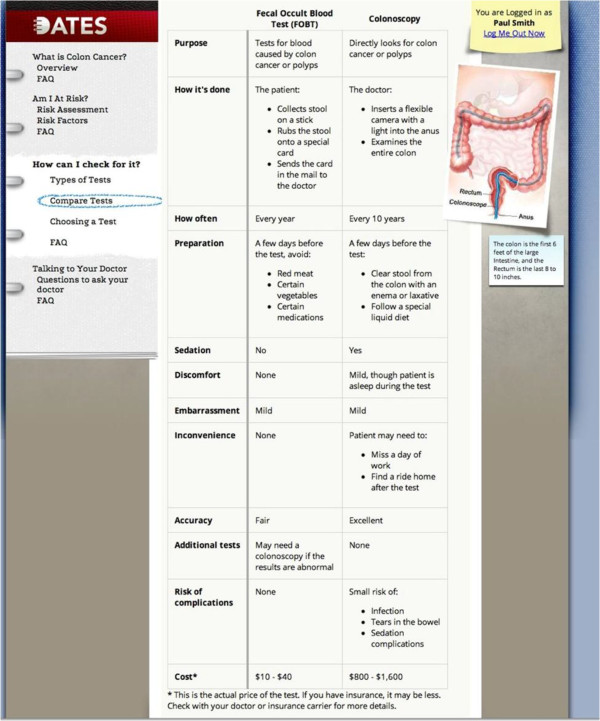
Screen shots of ColoDATES Web (Figures 2A-2E).